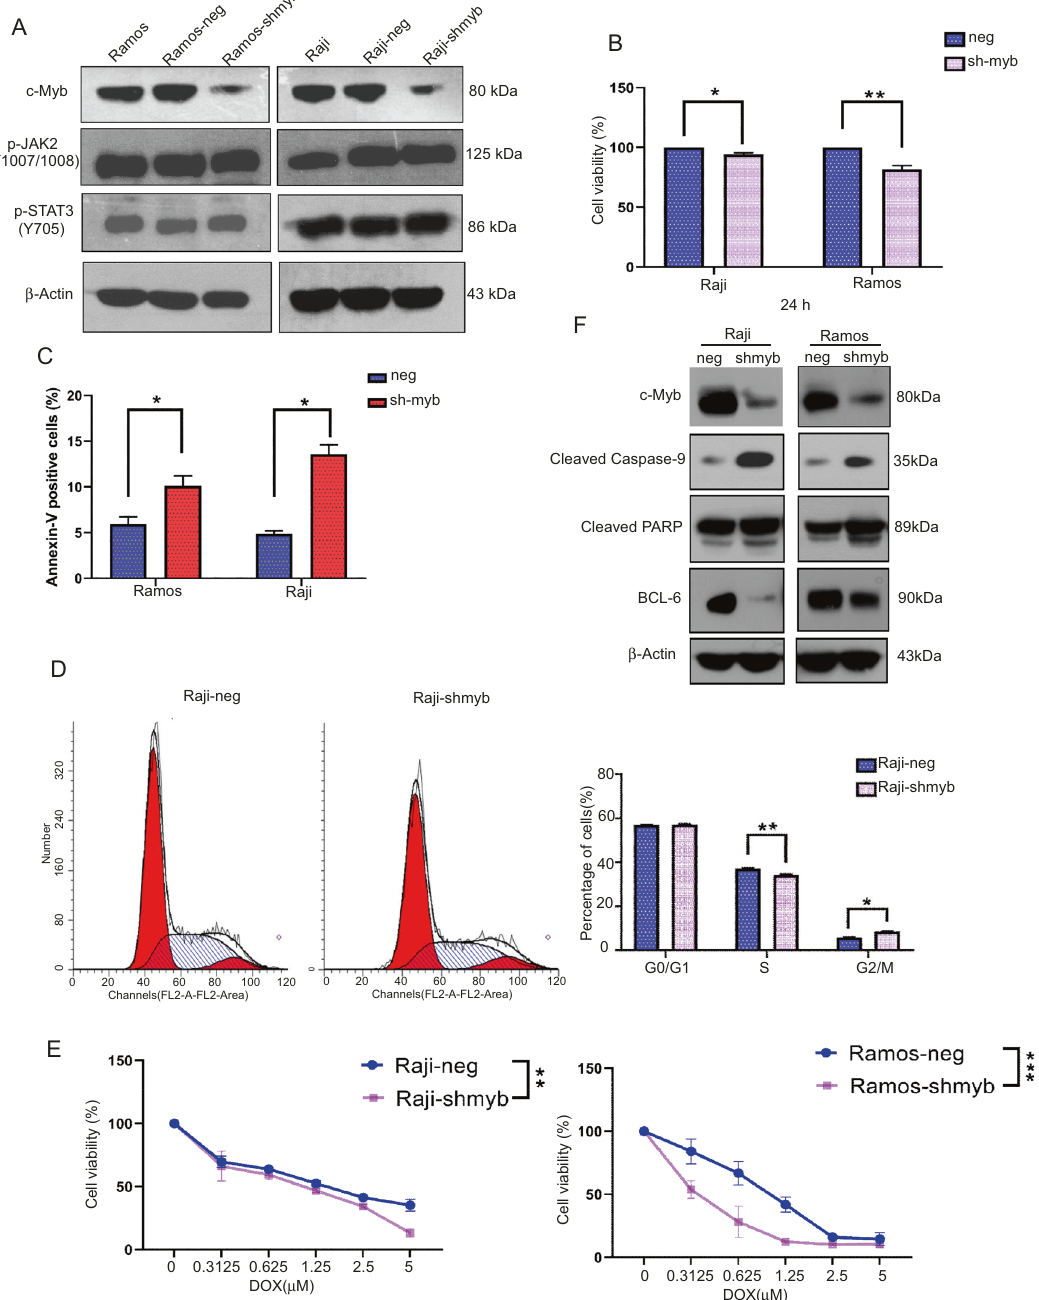
Fig. 5 Knockdown of C-Myb inhibits cell proliferation, arrests cell cycle, promotes apoptosis and cell sensitization to Doxorubicine of BL cells. A Western blot analysis was performed to detect the expression levels of c-Myb, p-JAK2 and p-STAT3 in Raji and Ramos cells transfected with myb-knockdown plasmid or vector control. B Raji and Ramos cells transfected with myb-knockdown plasmid or vector control were seeded in 96-well plate for 24 h, then OD was measured by the method of MTT. C Apoptotic cells were determined by fl ow cytometry analysis of annexin-V APC and 7-AAD, and the graph shows the percentages of annexin-V-positive (apoptotic) Raji and Ramos cells transfected with myb-knockdown plasmid or vector control. D Flow cytometric analysis of the cell cycle in Raji and Ramos cells transfected with myb- knockdown plasmid or vector control. E Raji and Ramos cells transfected with myb-knockdown plasmid or vector control were seeded in 96- well plate were treated with Doxorubicin at different concentrations for 24 h, and cell viability was determined by MTT assay. F Western blot analysis was performed to detect the expression levels of cleaved caspase-9, cleaved PARP and Bcl-6 in Raji and Ramos cells transfected with myb-knockdown plasmid or vector control. Data are presented as the mean ± SD, and the p values are shown (* p < 0.05, ** p < 0.01, *** p <